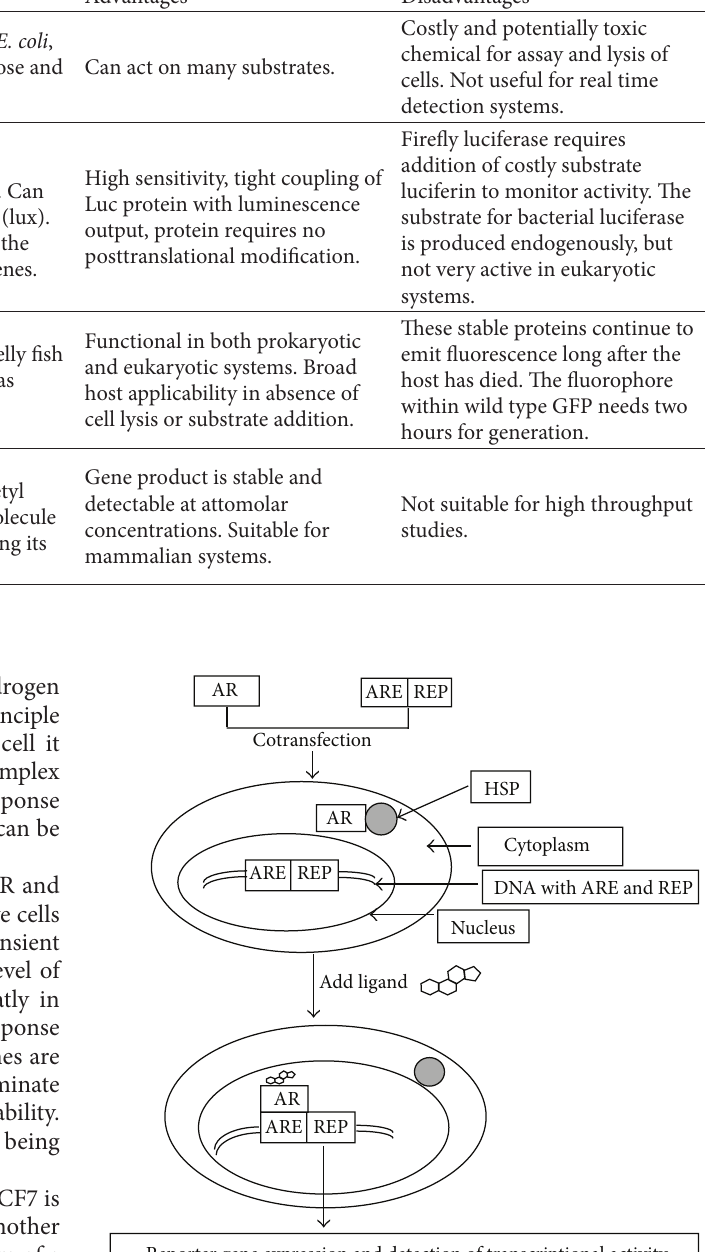
Figure 1: The principle of in vitro androgen transactivation assay, based on stable transfection of a cell line with two plasmids; one encoding the androgen receptor and the other, the androgen response element (ARE) upstream of a reporter (REP) gene such as luciferase. The unstimulated transfected cell expresses both AR and ARE-REP and the AR remains in cytoplasm bound to heat shock proteins (HSP). When the transfected cell is exposed to an androgen such as DHT, the AR moves into the nucleus, dimerizes, binds to ARE, and triggers expression of REP which can be monitored. The reporter gene expression correlates with bioactivity of androgen in the sample. Note: for simplicity only AR monomer binding to ARE has been